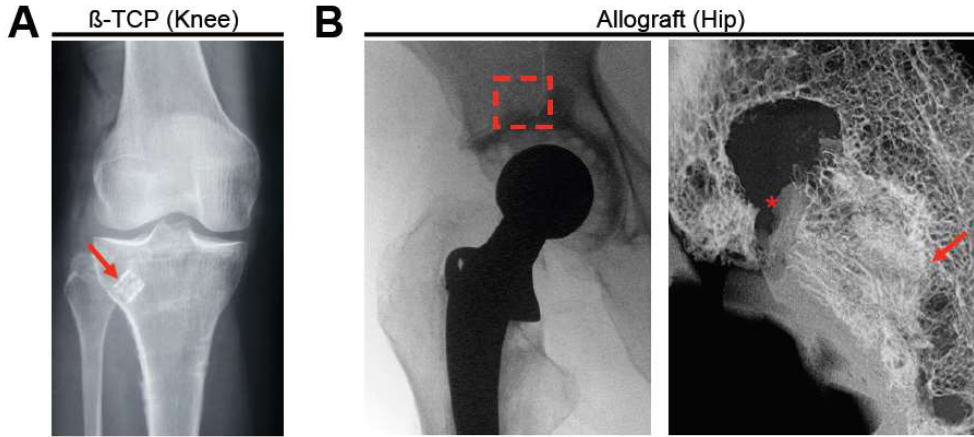
Figure 1. Clinical examples (radiographs) of two different bone substitute types. ( A ) beta-tricalcium phosphate ( β -TCP) block (red arrow) used in a patient with a multi-fragment proximal tibia fracture. Adapted from [1]. ( B ) Implantation of a structural allograft in revision total hip arthroplasty, left: clinical radiograph (red box indicates the area where the allograft was implanted), right: post-mortem high-resolution contact radiograph. * indicates absent area with no contact, arrow indicates close contact between the graft and the host bone.